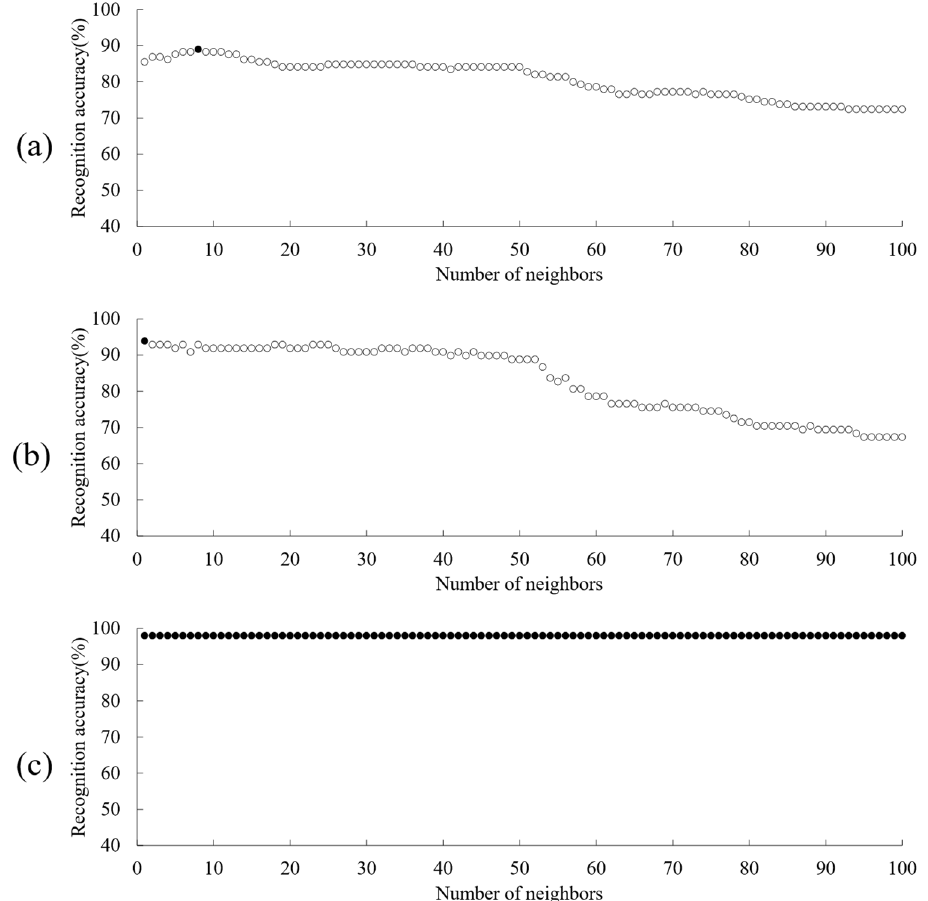
Figure 5. Model performance optimization. ( a ) DPC-CWT-LDA-KNN; ( b ) DDFP-OS-LDA-KNN; ( c ) AFWT-OS-LDA-KNN. ( • —Optimal RA).